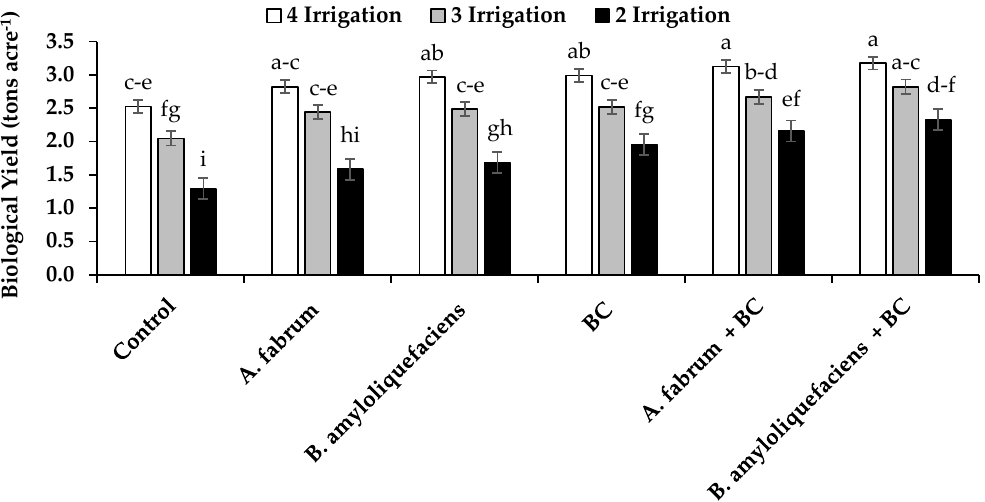
Figure 2. Effect of Agrobacterium fabrum , Bacillus amyloliquefaciens with/without biochar (30 Mg ha − 1 ) on straw yield (tons acre − 1 ) in wheat cultivated in drought-stressed field conditions.